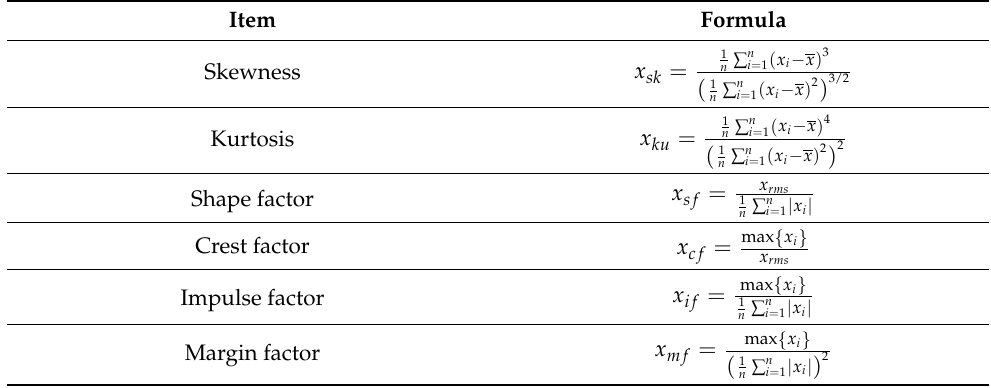
Figure 6. Feature variations in the discharging stage related to cycles. Table 3. Time-domain metric